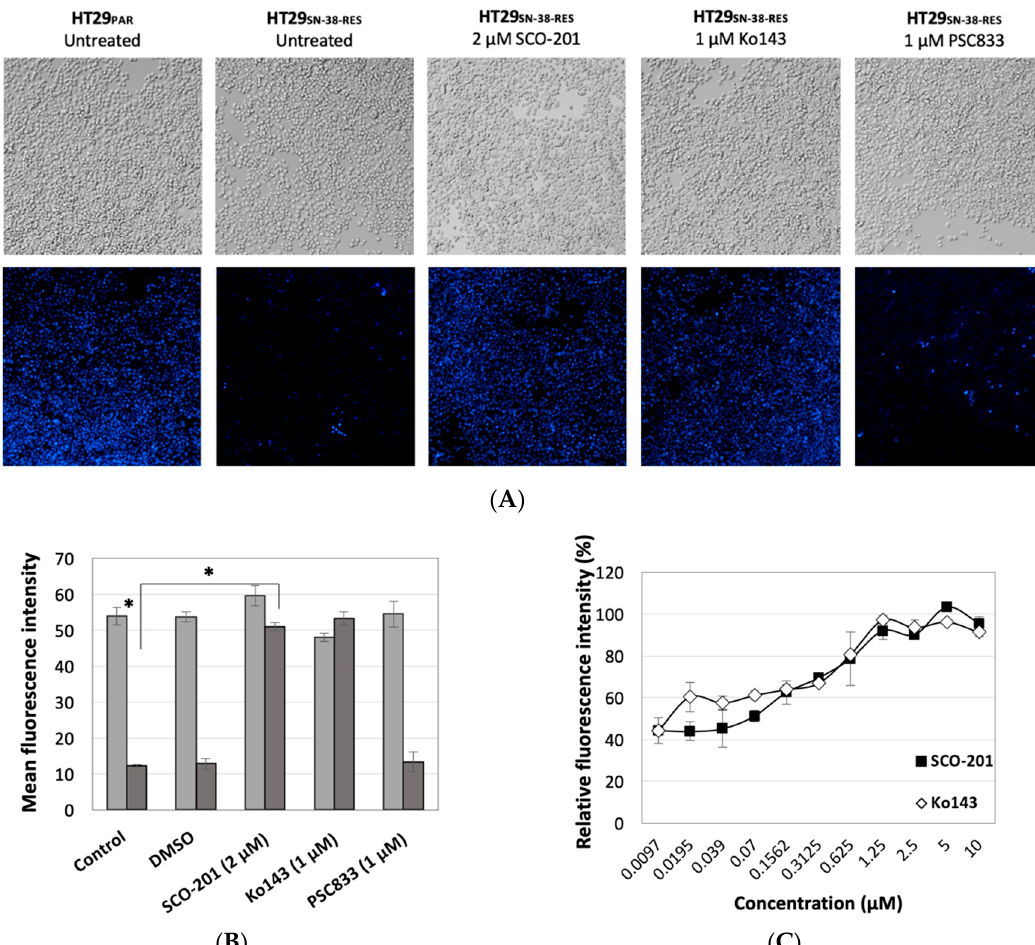
Figure 4. SCO-201 inhibited the efflux of Hoechst 33,342 from HT29 SN-38-RES cells. ( A ) Fluorescence micrographs of Hoechst-stained parental HT29 cells (HT29 PAR ) and HT29 SN-38-RES cells that were incubated with either SCO-201, the BCRP-inhibitor Ko143, or the MDR1-inhibitor valspodar (PSC833) . Full growth medium was used for the control condition. Untreated parental HT29 cells were included as a positive control, indicating the maximal accumulation of Hoechst dye, as these cells do not overexpress BCRP. ( B ) Mean fluorescence intensity of Hoechst-stained SN-38-sensitive (light grey) and SN-38 resistant (dark grey) HT29 cells treated with either DMSO, SCO-201, Ko143, or PSC833. Full growth medium was used for the control condition. The asterisks (*) indicate statistical significance ( p < 0.05). (C) The dose-dependent effects of SCO-201 and Ko143 on the accumulation of Hoechst, indicated by the increase in relative fluorescence intensity of Hoechst-stained HT29 SN-38-RES cells. Error bars in ( B , C ) indicate SD determined from triplicate experiments.